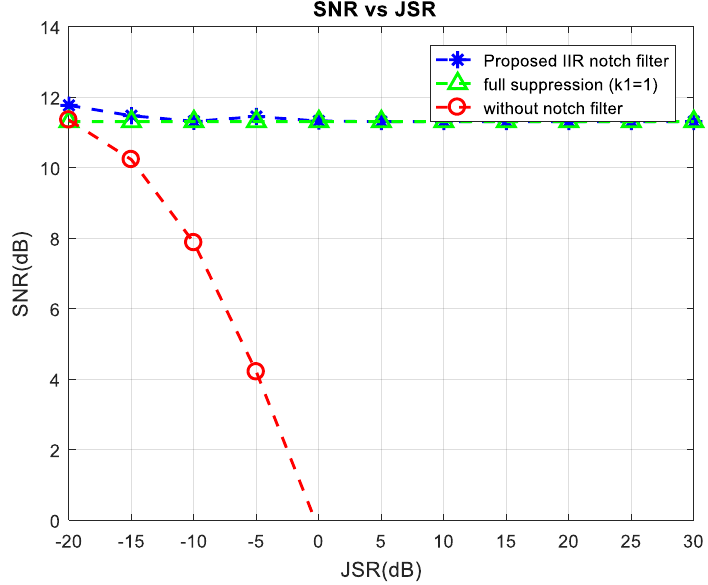
Figure 18. SNR vs. JSR, with Eb/No = 15 dB.